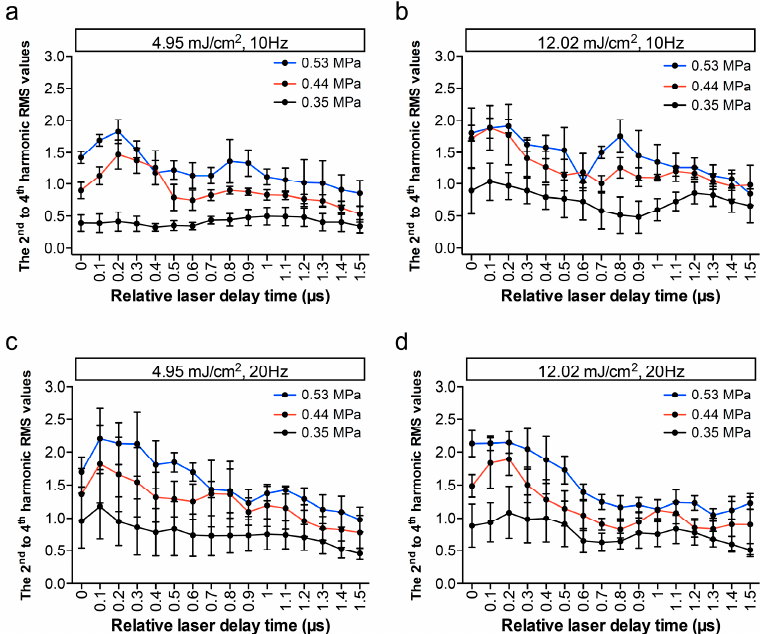
Figure 5. AuNDs vaporization triggered using ultrasound and laser simultaneously. The 2 nd to 4 th harmonic RMS values were plotted as a function of relative laser delay time. In each individual experiment, 200 recordings were collected at ( a ) 4.95 mJ / cm 2 , 10 Hz; ( b ) 12.02 mJ / cm 2 , 10 Hz; ( c ) 4.95 mJ / cm 2 , 20 Hz; and ( d ) 12.02 mJ / cm 2 , 10 Hz. Lines labeled in di ff erent colors denote di ff erent driving acoustic PNPs in each figure. Each point indicates the mean and SD for three individual experiments.